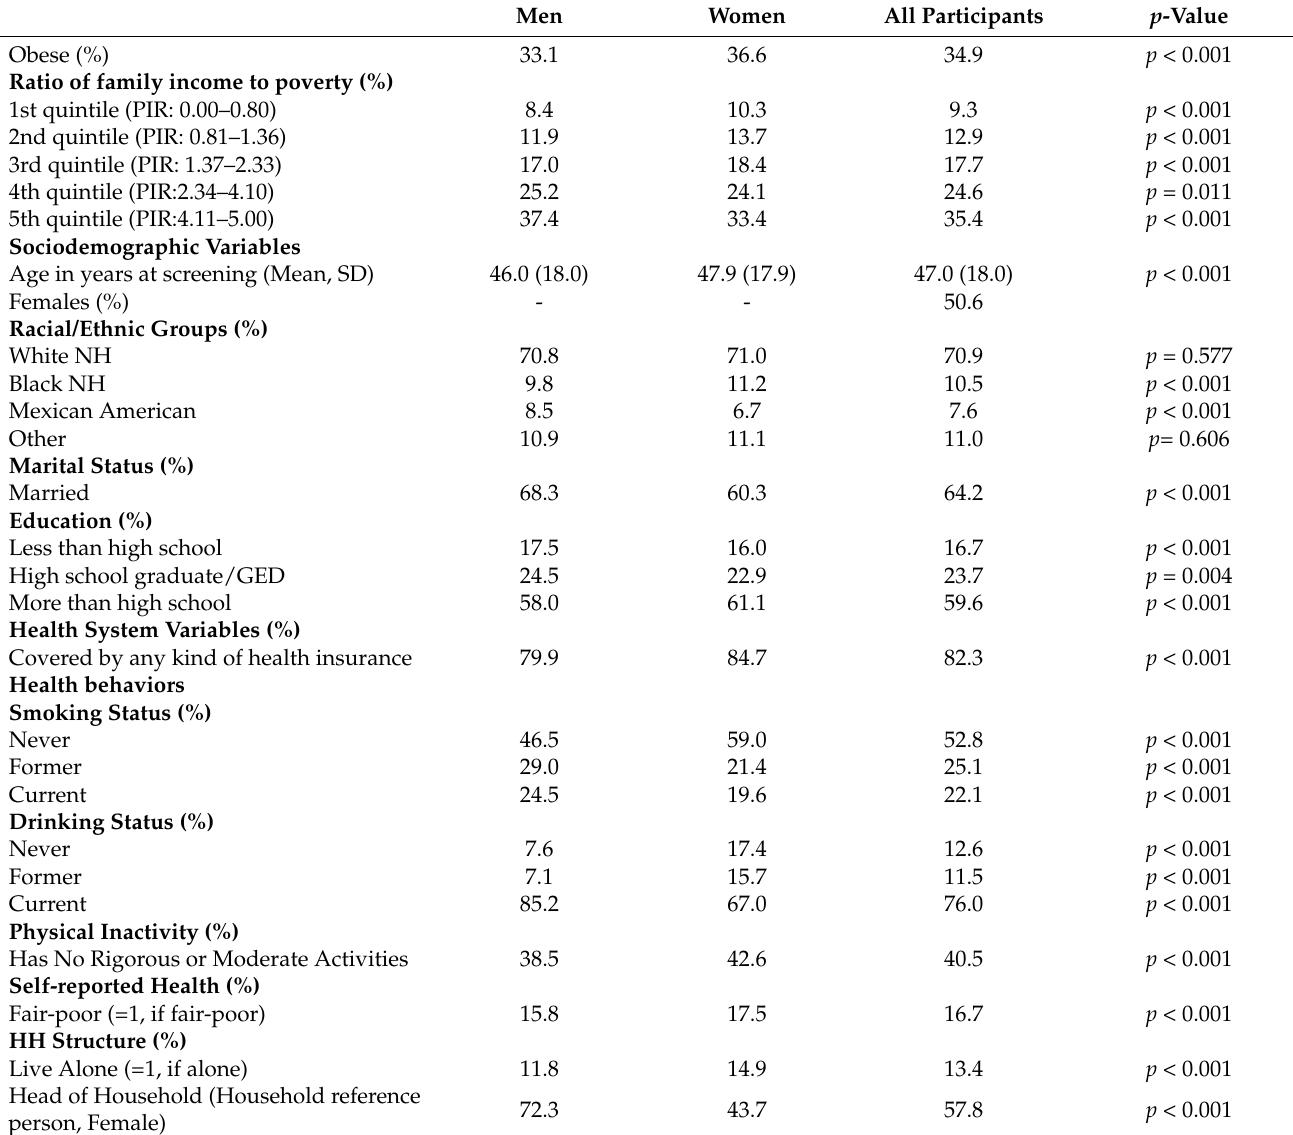
Table 1. Comparing study sample characteristics between men and women, US Adults over 20 years of age in 1999–2016 National Health and Nutrition Examination Survey (N =